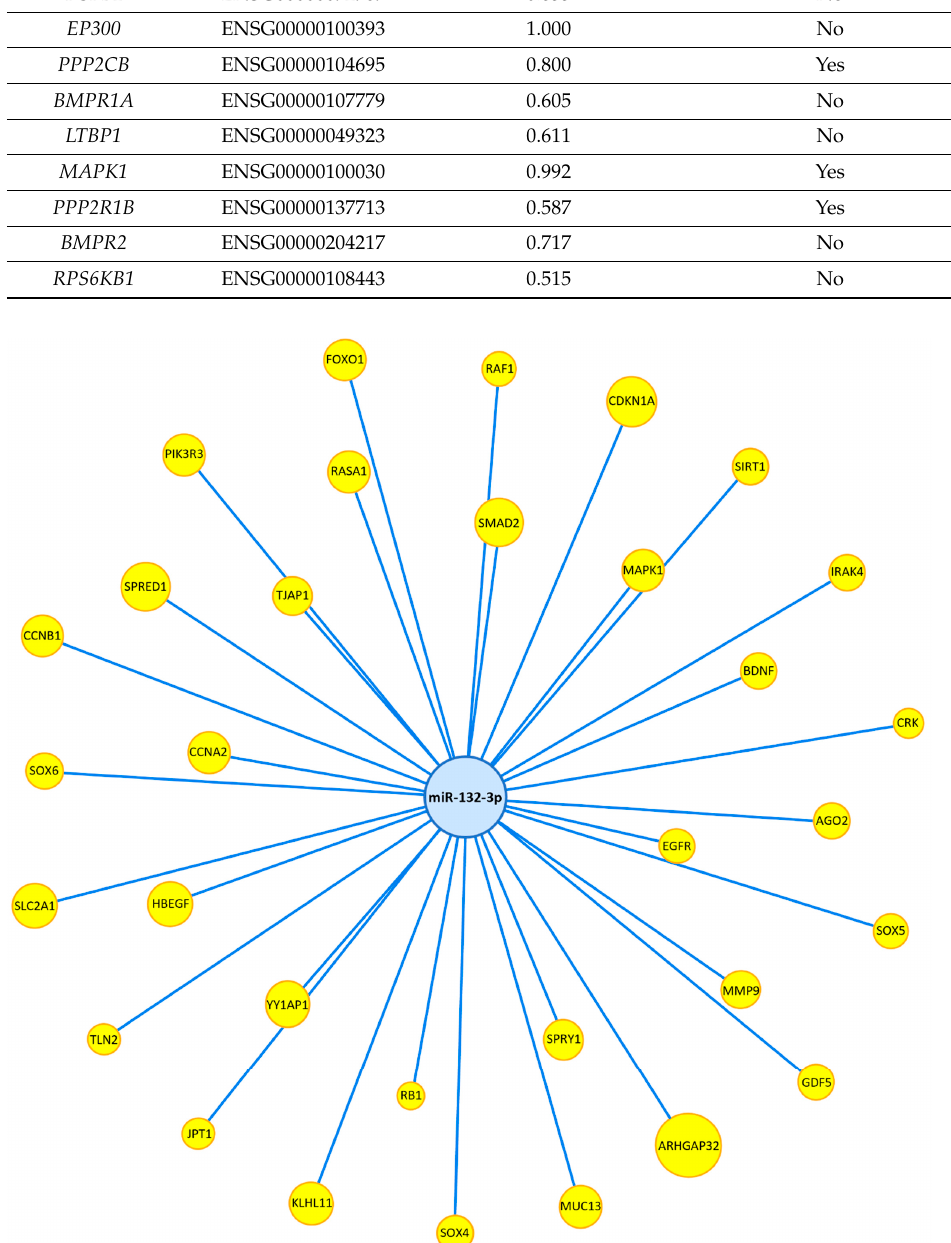
Figure 8. MiR-132-3p target interaction network. All miR-132-3p targets are experimentally validated (Western blot and luciferase assay) as curated by miRTarbase. Yellow nodes represent miR-132-3p target genes. Edges indicate gene–miRNA interactions. Nodes are sized appropriately to fit gene/miRNA names.